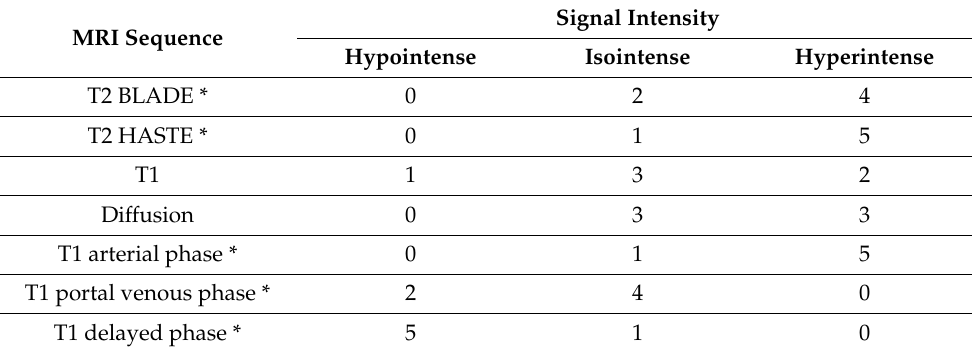
Table A1. Distribution of MRI signal characteristics in six patients with residual tumor tissue after IRE of an